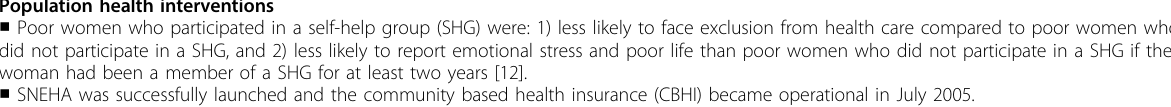
Table 2 Key findings from Phase I Social inequalities in health ■ Caste and socioeconomic inequalities in women ’ s health were observed: 1) women from lower castes reported a higher prevalence of poor health than women from high castes; 2) socioeconomic inequalities in health existed regardless of the indicator used (education, women ’ s employment status, or household landholdings; and 3) multilevel models indicated that among women with low caste affiliations, the influence of socioeconomic indicators led to a “ magnifying ” effect, whereas among women with high caste affiliations, a “ buffering ” effect was found [15]. Health of Paniyas ■ Compared to non-Paniyas, Paniyas reported: 1) the highest rates of poverty, 2) the lowest education levels; 3) the lowest utilization rates of health care facilities; 4) the highest household expenditure on alcohol; 5) the worst access to safe drinking water and sanitation facilities, and 6) the poorest housing conditions [project profiles].